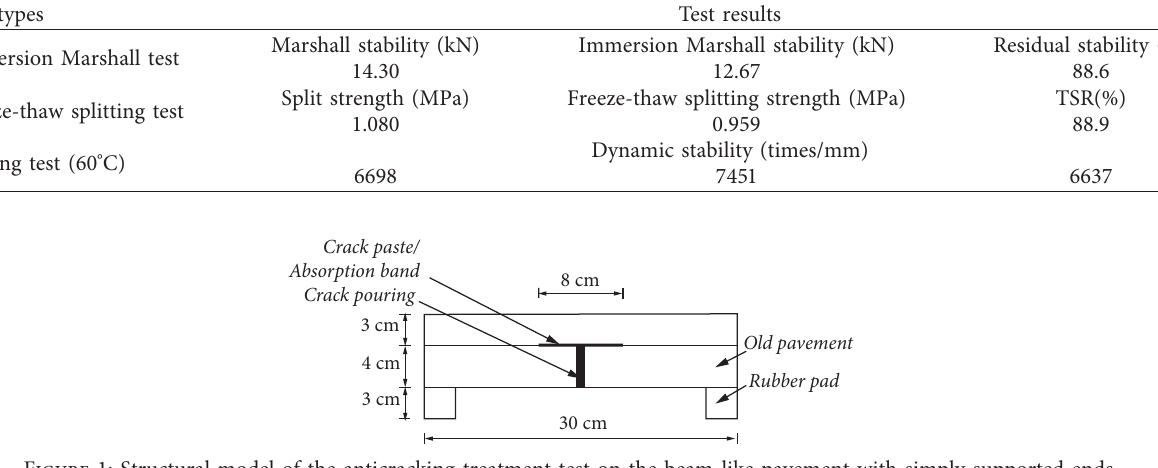
Table 2: Performance index test of AC-13C asphalt mixture.